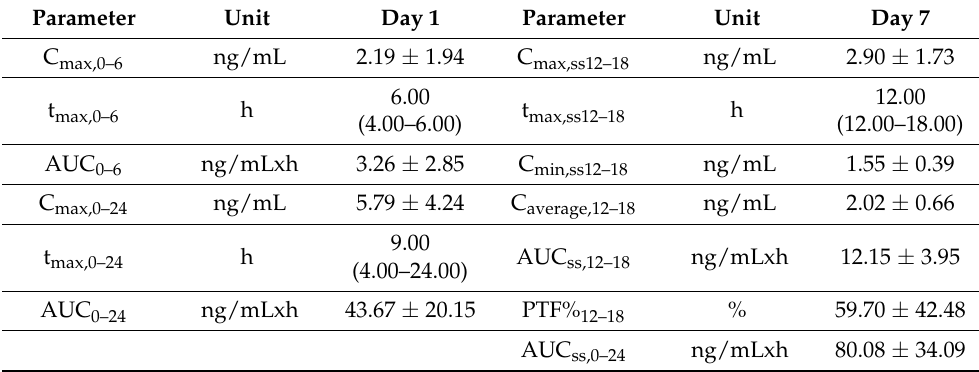
Figure 1. Mean (+SD) rifamycin SV concentration (ng/mL) vs. time profiles on Day 1 ( ○ solid line) and Day 7 ( □ dashed line) of treatment with 600 mg modified release tablets t.i.d. (times a day). Linear scale. N = 18; 1: rifamycin SV concentrations on Day 1; 7: rifamycin SV concentrations on Day 7; Dashed vertical lines indicate the timing of the second and the third daily doses. Table 5. Pharmacokinetic parameters of plasma rifamycin SV measured and calculated on Days 1 and 7 of treatment (N = 18).